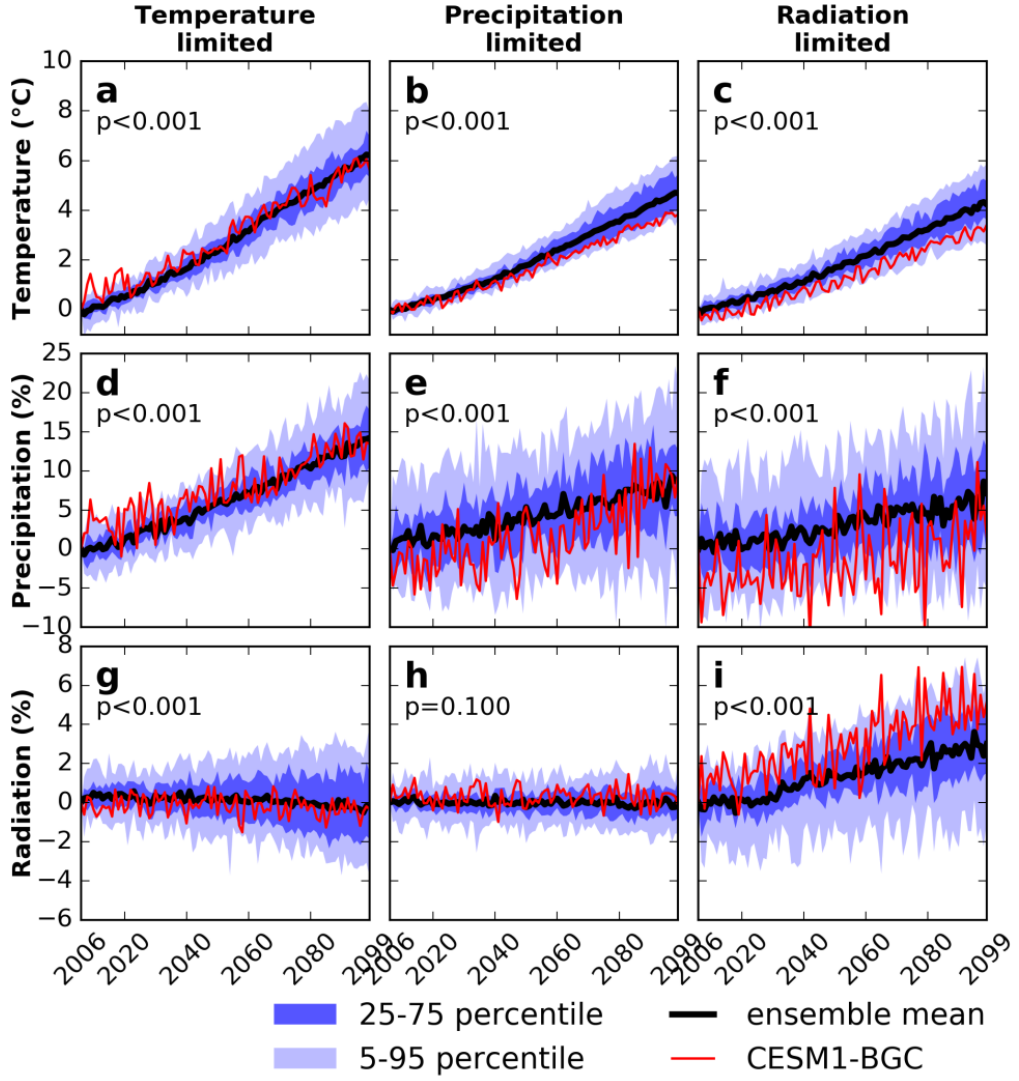
Figure 3. Climate responses from the Earth system models of CMIP5, summarized over the three climate-limiting regions. The simulations represent RCP 8.5, a pathway with the highest greenhouse gas emissions. Ensemble means and the percentiles show progressive relief of the main limiting factor for each region. Models diverge substantially towards the end of the simulation period, but almost all trends are statistically significant (see p-values in each panel). Changes in temperature ( a – c ), precipitation ( d – f ), and radiation ( g – i ) are expressed as percent of initial values in 2006. Outputs of Community Earth System Model, version 1–Biogeochemistry (CESM1-BGC), red line, are shown as examples of results from Earth system models incorporating nitrogen cycling. The p-value was calculated from Mann–Kendall trend test.